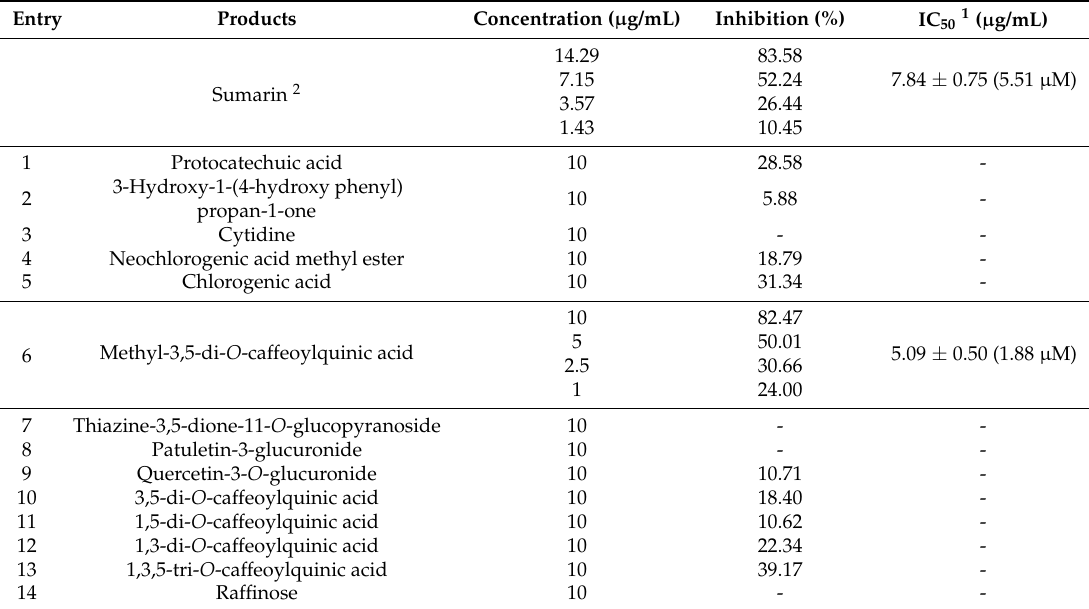
Table 4. Inhibitory effect of isolated compounds from X. strumarium on protein tyrosine phosphatase 1 β (PTP1 β